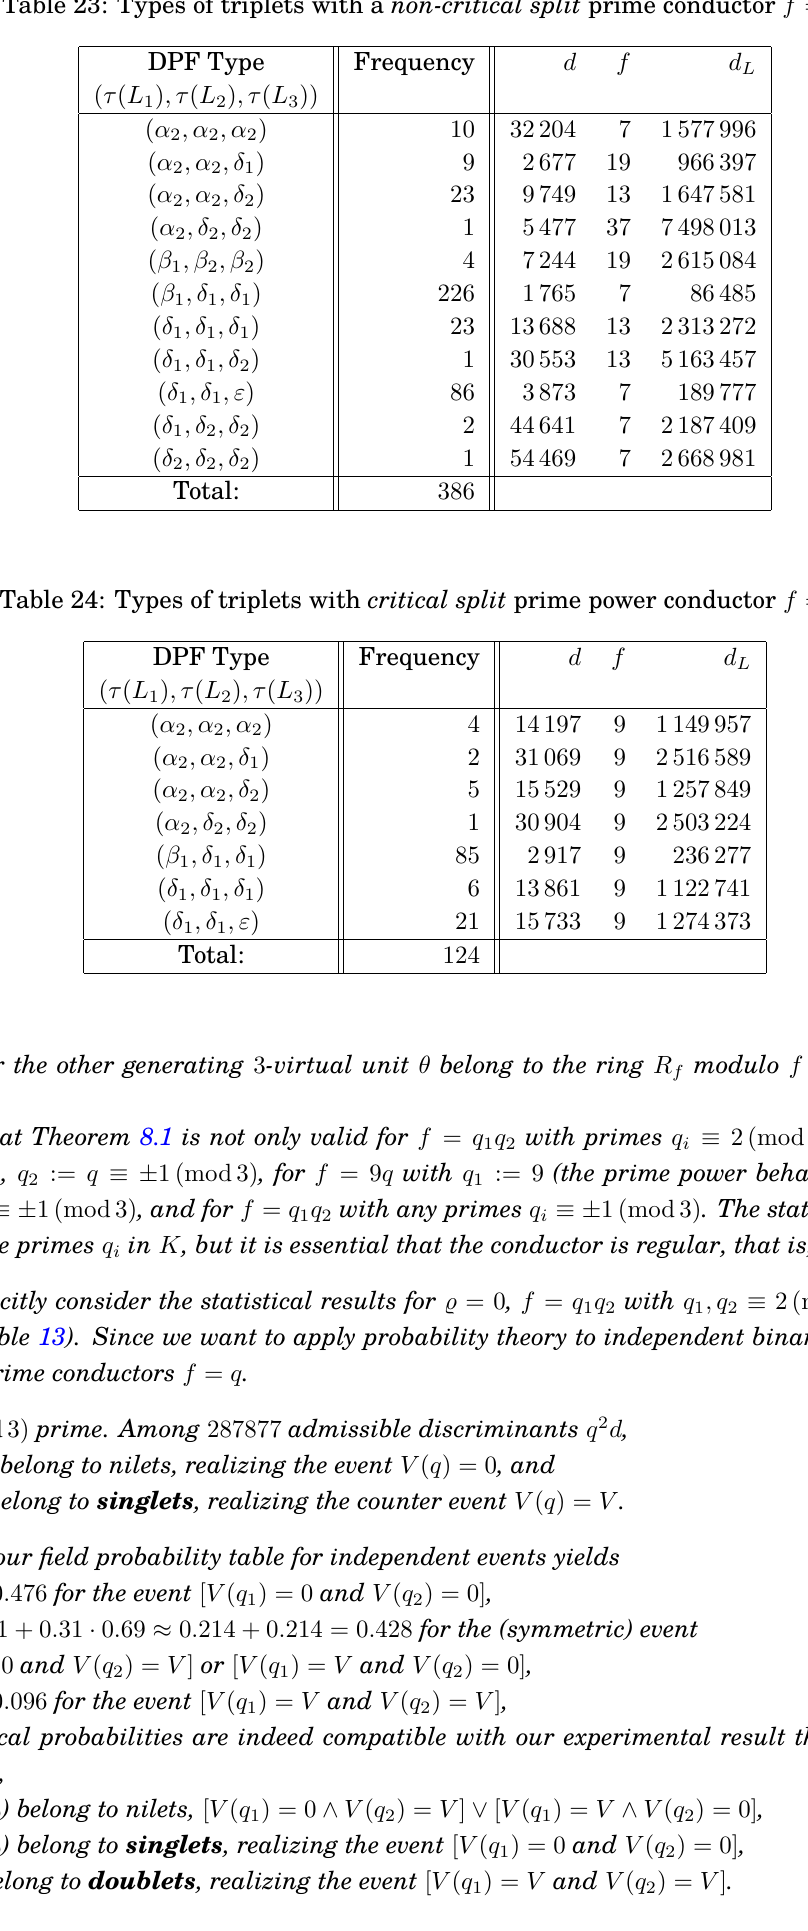
Table 23: Types of triplets with a non-critical split prime conductor f = (cid:96) .